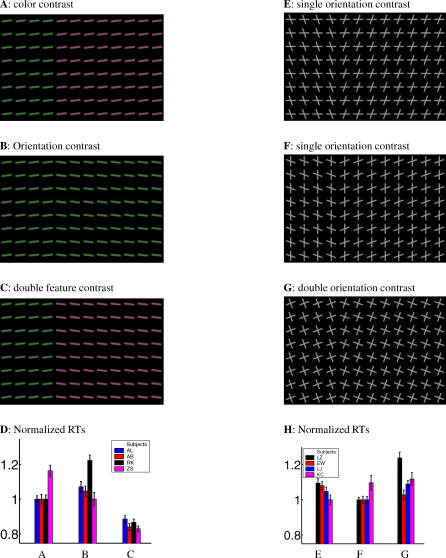
Small Portions of Actual Stimuli and Data in the Test of the Predictions of Saliency Advantage in Color-Orientation Double Feature (Left, [A–D]) and the Lack of It in Orientation–Orientation Double Feature (Right [E–H])(A–C) Texture segmentation stimuli by color contrast, or orientation contrast, or by double color–orientation contrast.(D) Normalized RTs for the stimulus conditions (A–C). Normalization for each subject is by whichever is the shorter mean RT (which for the subjects AL, AB, RK, and ZS are, respectively, 651, 888, 821, and 634) of the two single-feature contrast conditions. All stimulus bars had color saturation suv = 0.2, and were ±7.5° from horizontal. All subjects had their RT for the double-feature condition significantly shorter (p < 0.001) than those of both single-feature conditions.(E–G) Texture-segmentation stimuli by single- or double-orientation contrast, each oblique bar is ±20° from vertical in (E) and ±20° from horizontal in (F), and (G) is made by superposing the task-relevant bars in (E) and (F).(H) Normalized RTs for the stimulus conditions (E–G) (analogous to [D]). The shorter mean RT among the two single-feature conditions are, for four subjects (LZ, EW, LJ, KC), 493, 688, 549, 998 ms, respectively. None of the subjects had RT for (G) lower than the minimum of the RT for (E) and (F). Averaged over the subjects, the mean normalized RT for the double-orientation feature in (G) is significantly longer (p < 0.01) than that for the color-orientation double feature in (C).